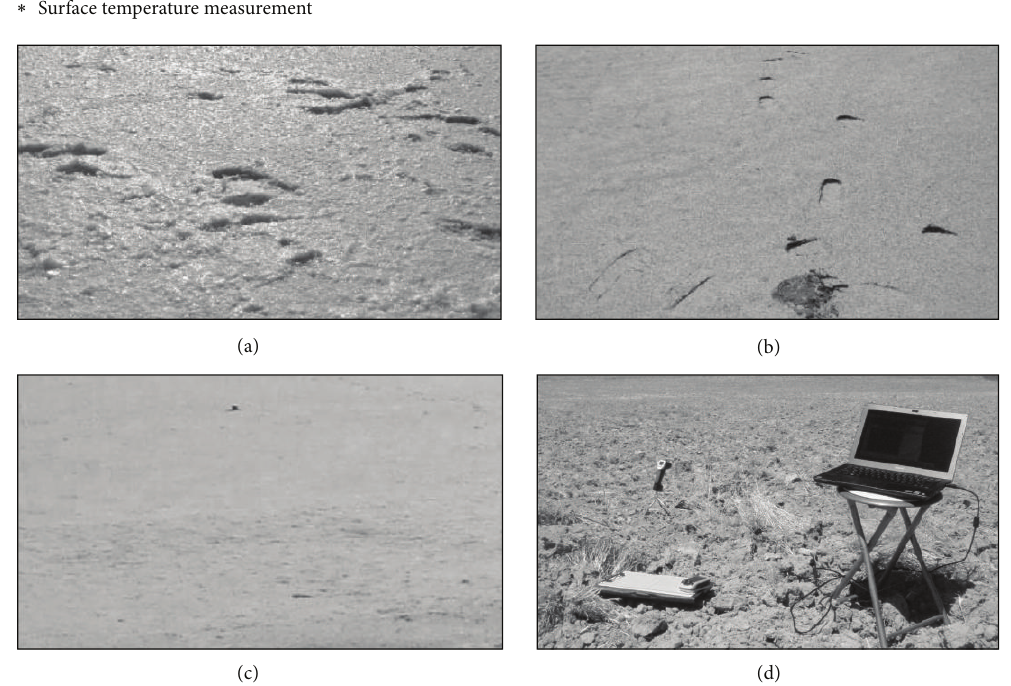
Figure 2: The details of the real-time field measurements performed with the overpass of Landsat-5 (real-time measurements were collected on August 21, 2011 07:30–11:00 AM, GMT+2). Landsat-5 overpass: 08:21 AM over the Salt Lake, Turkey (path/row = 177/033). (a) Salt, (b) bare saline soil, (c) crusted saline soil, and (d) fallow